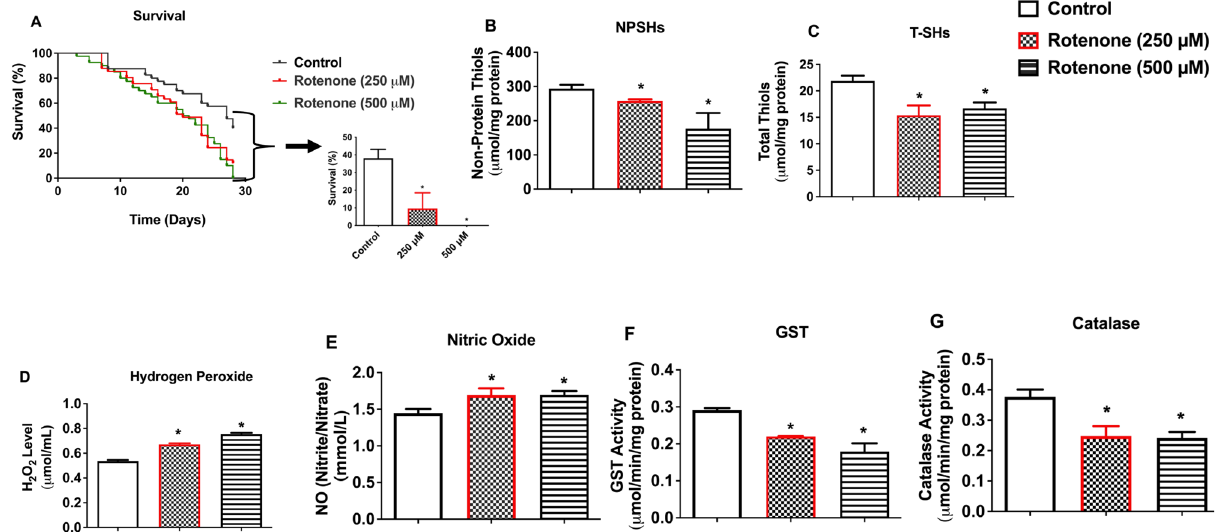
Figure 2. Effects of rotenone (250 and 500 μM) on 30-day survival rate ( A ), levels of NPSHs ( B ), T-SHs ( C ), H 2 O 2 ( D ), NO ( E ), and activities of the enzymes GST ( F ) and Catalase ( G ) in D. melanogaster . Data in ( A – G ) are presented as Mean ± SEM of 50 flies per vial (five replicates per group). *Significant difference compared with control group (p < 0.05). NPSHs non-protein thiols, T-SHs total thiols, H 2 O 2 hydrogen peroxide, GST glutathione-S-transferase, AChE acetylcholinesterase